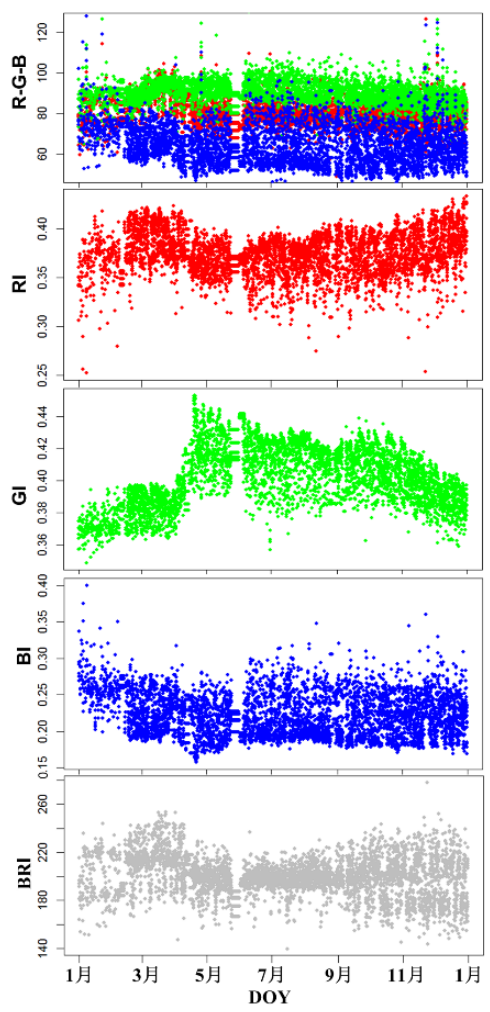
Figure 5. Four kind of relative vegetation index (freemanwood,